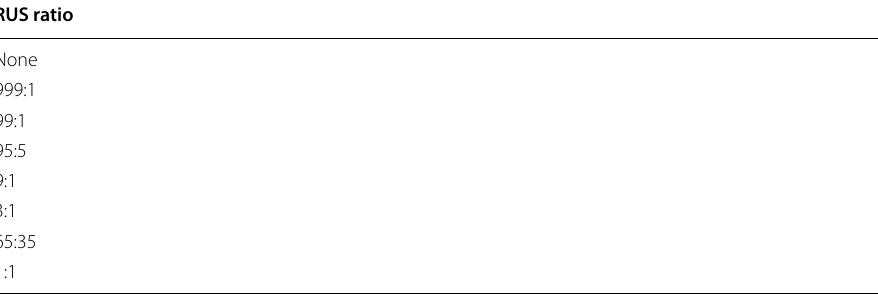
Table 7 Random undersampling (RUS) sampling ratio levels applied RUS ratio